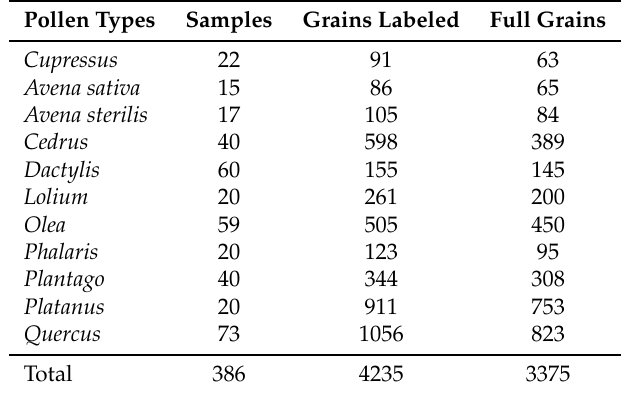
Table 2. Composition of the pollen database showing the registered samples, the number of grains labeled, and complete grains identified by